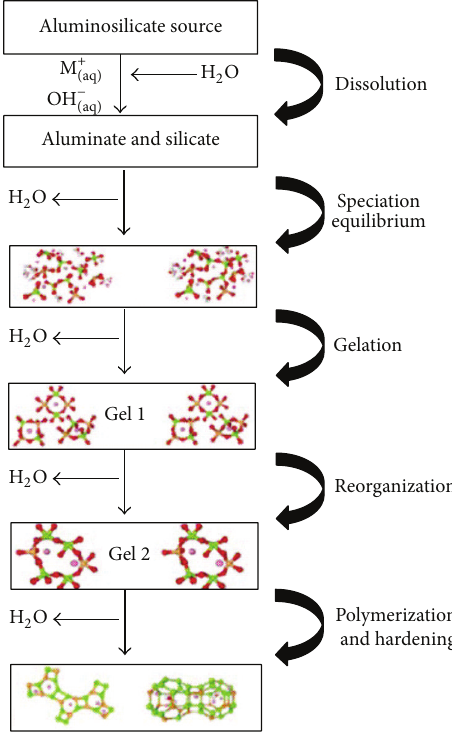
Figure 2: Geopolymerisation-conceptual model